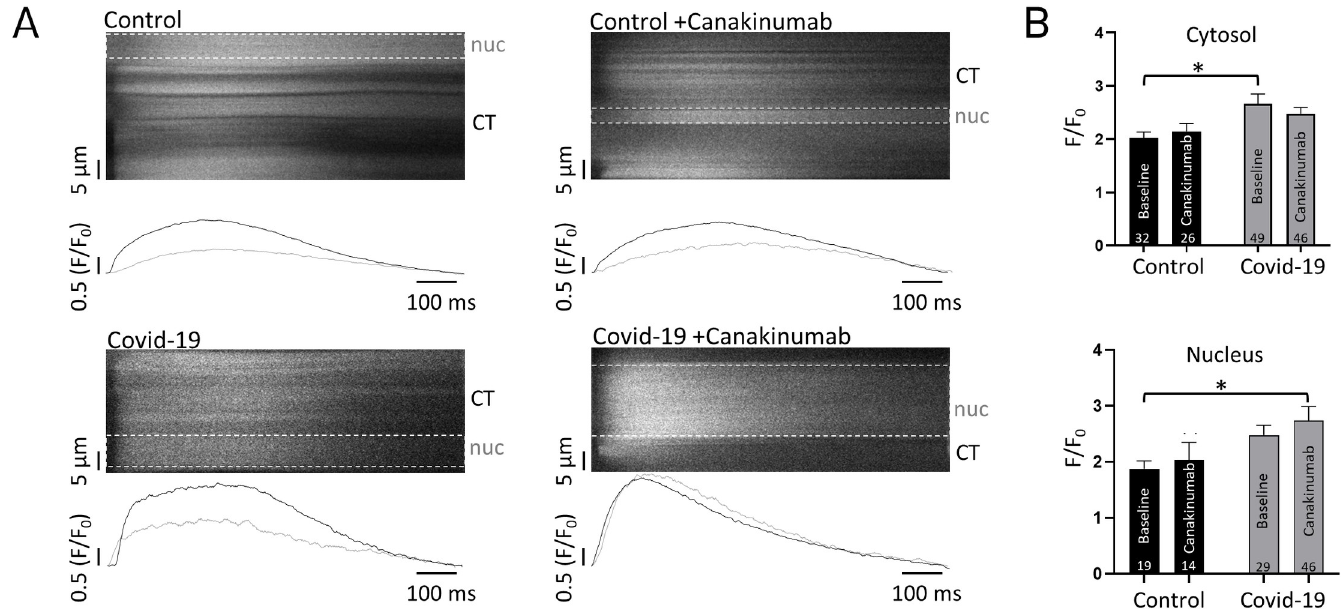
Fig 3. Ca 2+ transients during electrical stimulation of iPS-CM upon addition of COVID19 serum. (A) Example Ca 2+ transients as obtained after 24 hours incubation with serum +/- Canakinumab; iPS-CM during 1Hz electrical field stimulation. (B) Quantification of cytosolic (top) and nuclear (bottom) peak Ca 2+ transient amplitudes. � p <